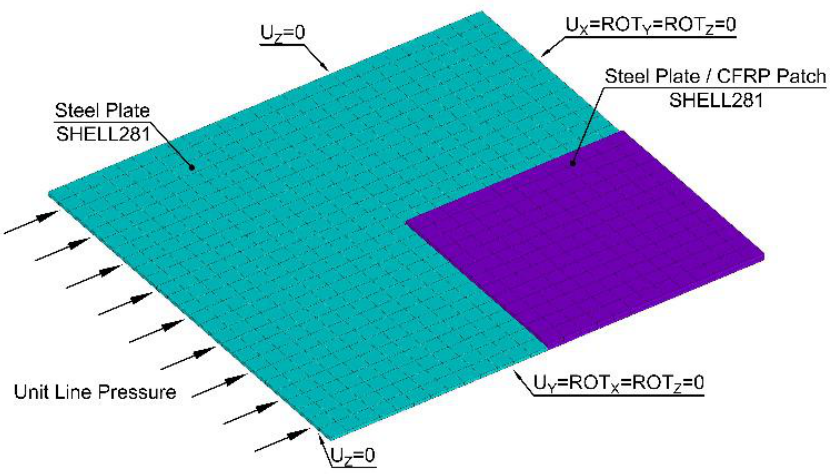
Figure 7. FE mesh of the repaired plate’s quarter model with element/section assignments and boundary/loading conditions.